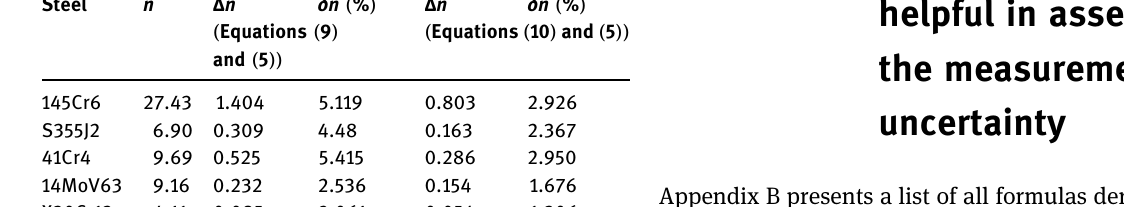
Table A1: The absolute and relative error values of strain hardening exponent n for steels used in this article